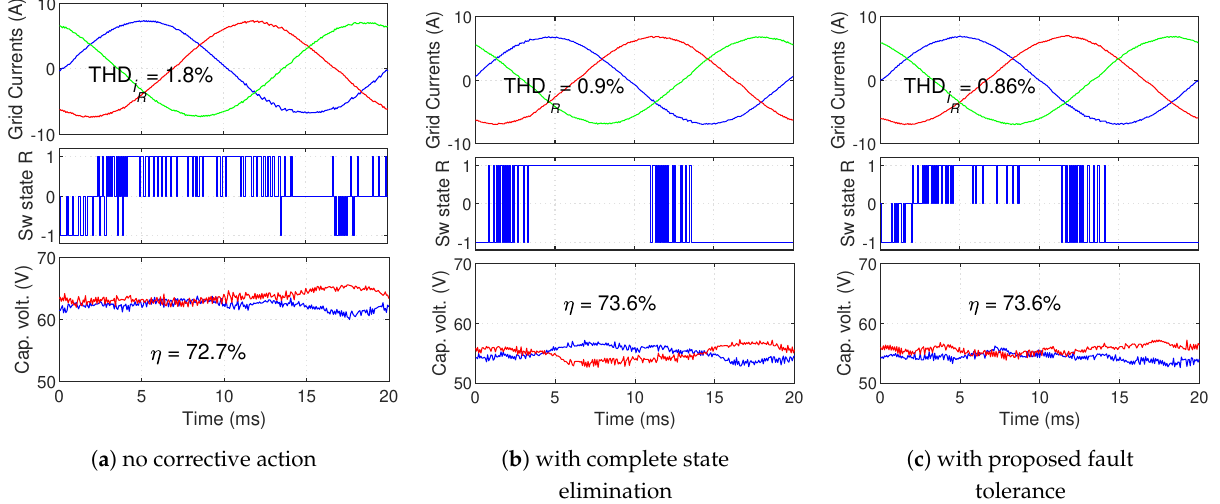
Figure 17. Steady-state operation after a fault in clamp diode D R 5 , with different corrective